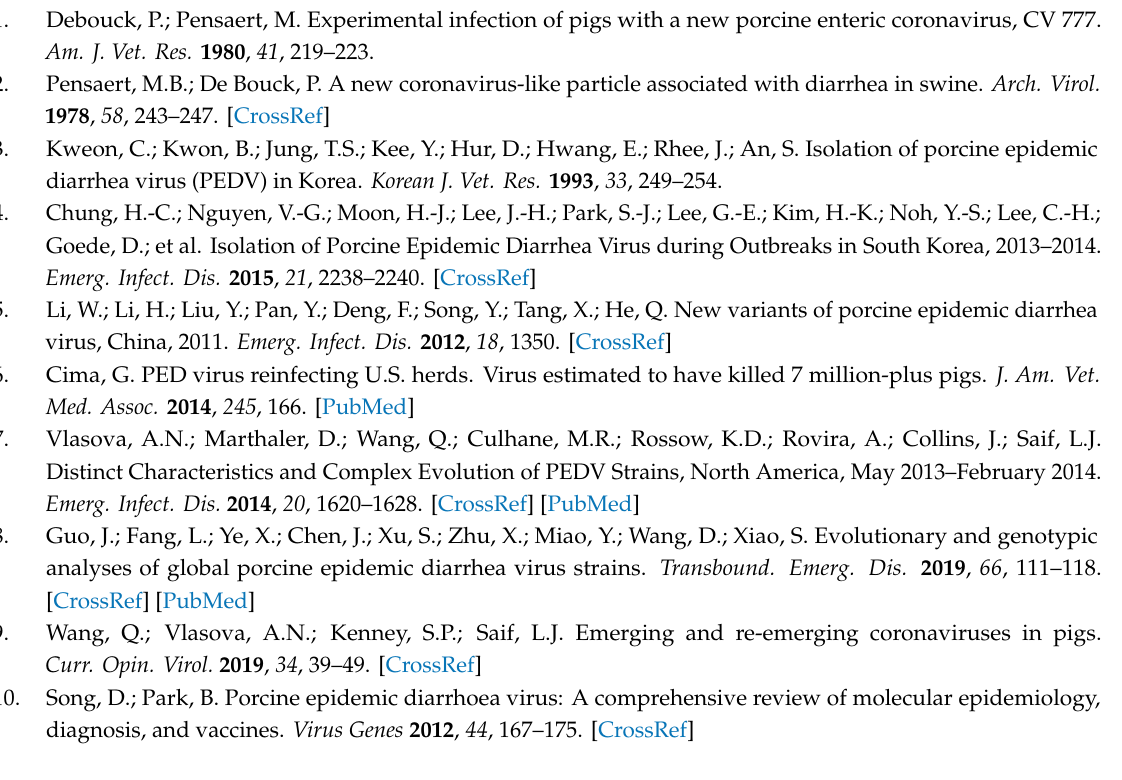
Figure S1: Supplementary material-Figure-S1-S-nu-al-BMT-RLC-Const. Figure S2: Supplementary material-Figure-S2-S -nu-no-rec-regions-BMT-RLC-Expo. Figure S3: Supplementary material-Figure-S3-N-nu-al-BMT-RLC-Const, Figure S4: Supplementary material-Figure-S4-N-nu-no-rec-regions-BMT-RLC-BSP. Figure S5: Supplementary material-Figure-S5-N-substitutions-mapping-tree. Table S1: Supplementary-material-Table-S1-model-comparison-1. Table S2: